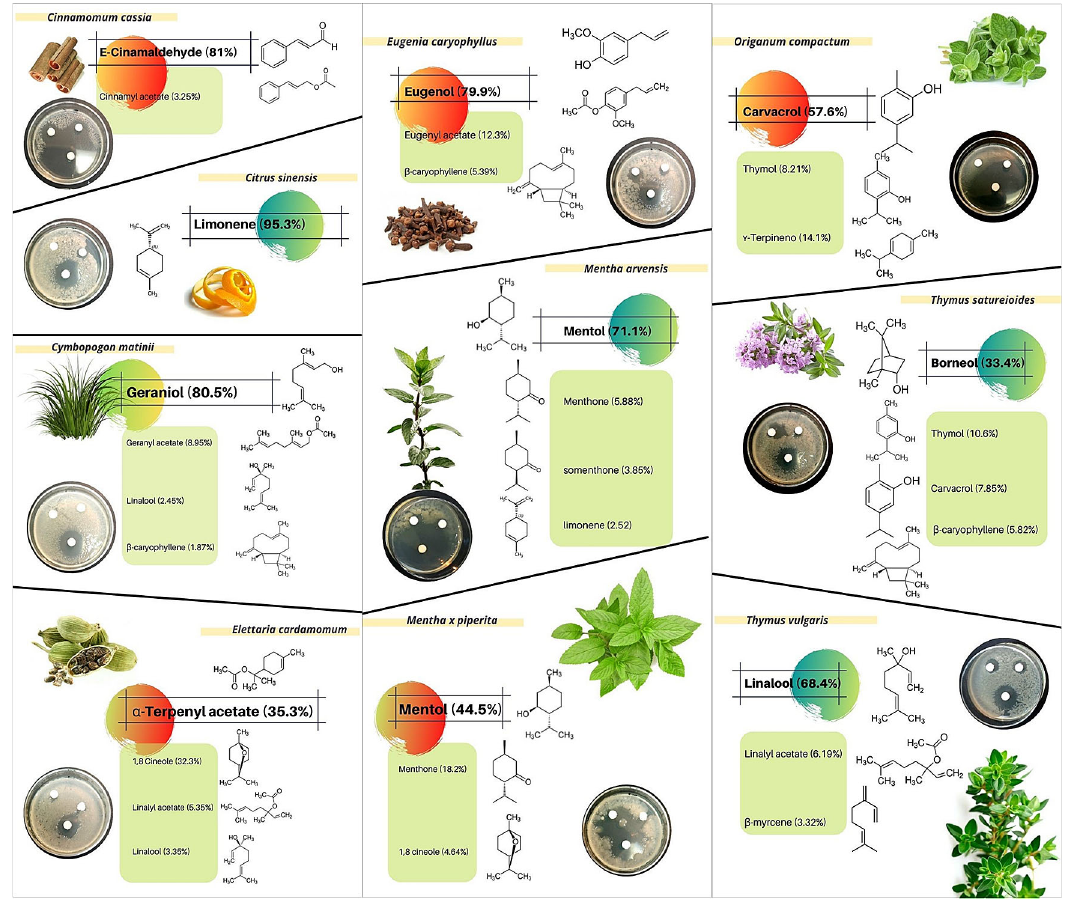
Figure2.Antimicrobial activityof Cymbopogonmatinii var.motia , Elettariacardamomum, Eugeniacaryophyllus, Mentha x piperita, Thymus vulgaris CT Linanol and Thymus satureioides by the diffusion method against Bacillus subtilis. Likewise, the major and biologically bioactive constituents present in the six essential oils are shown.